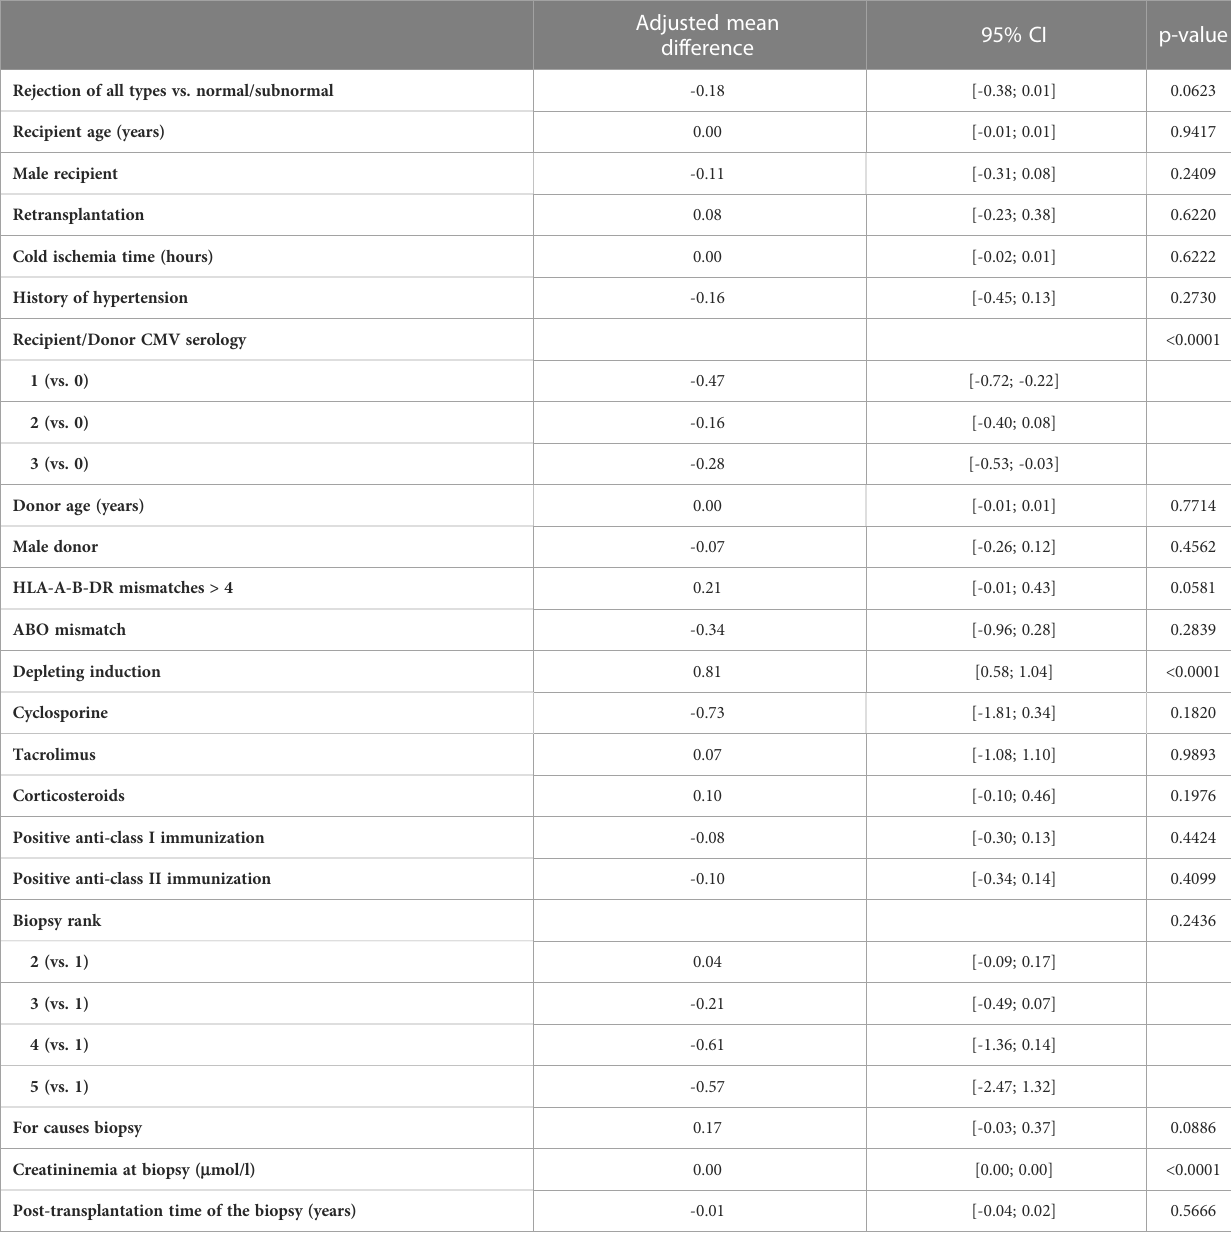
TABLE 3 Results of the multivariable linear mixed model of square root of B lymphocytes in percentage measured at the time of biopsy (Rejection of all types versus